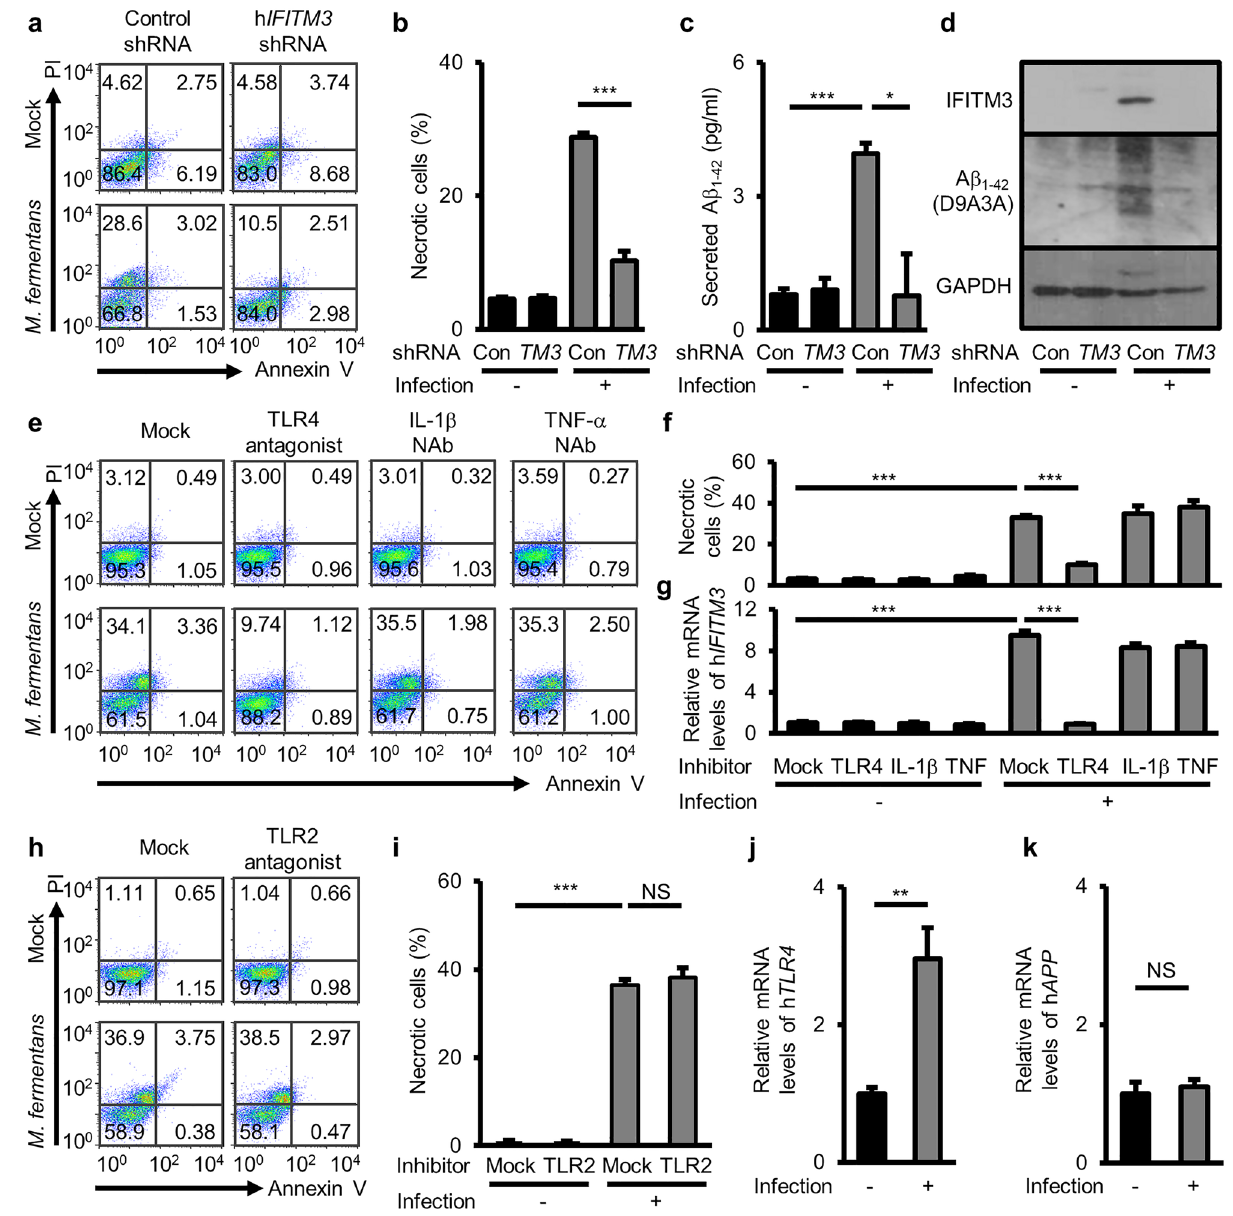
Figure 5. M. fermentans induces IFITM3-mediated Aβ 1-42 accumulation, resulting in necrotic neuronal cell death. ( a ) Representative flow cytometry dot plots from Annexin V/PI apoptosis assays for mock- or M. fermentans -infected indicated gene knockdown SH-SY5Y cells at 12 dpi. ( b ) Bar graph of Annexin V-negative PI-positive cells for data from ( a ). ( c ) Quantification of secreted Aβ 1−42 in the SH-SY5Y culture medium from ( a ) determined by ELISA. ( d ) Representative western blotting image from mock- or M. fermentans -infected indicated gene knockdown SH-SY5Y cells using the indicated antibodies at 12 dpi. ( e ) Representative flow cytometry dot plots from Annexin V/PI apoptosis assays of mock- or M. fermentans- infected SH-SY5Y cells after TLR4 antagonist or the indicated neutralizing antibody (NAb) treatment. ( f ) Bar graph of Annexin V-negative PI-positive cells from ( e ). ( g ) Bar graph of h IFITM3 gene expression levels normalized against the GAPDH gene in infected SH-SY5Y cells from ( e ). ( h ) Representative flow cytometry dot plots from Annexin V/ PI apoptosis assays of mock- or M. fermentans -infected SH-SY5Y cells after treatment with TLR2 antagonist. ( i ) Bar graph of Annexin V-negative PI-positive cells from ( h ). ( j, k ) Bar graphs of gene expression levels of h TLR4 ( j ) and h APP ( k ) in infected SH-SY5Y cells at 12 dpi, which were determined by qPCR and normalized against the GAPDH gene. Original blots are presented in Supplementary Fig. S9. Con, control knockdown SH-SY5Y cells; TM3 , h IFITM3 knockdown SH-SY5Y cells; NAb, neutralizing antibody. Bar graphs present mean values ± SD; * p ≤ 0.05; ** p ≤ 0.01; *** p ≤ 0.001 (unpaired Student’s t-test). Data are averages of three or more independent